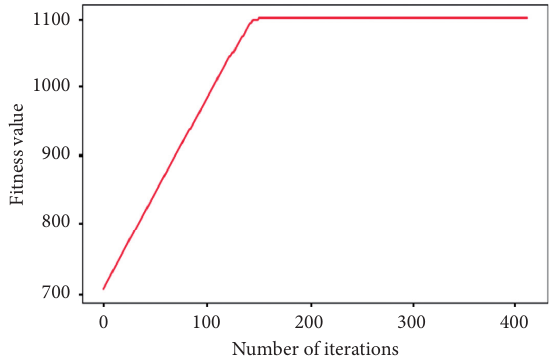
Figure 5: The convergence process of Algorithm 2. Algorithm 2 is converged at 140 generations and totally updates 252,000 individuals.